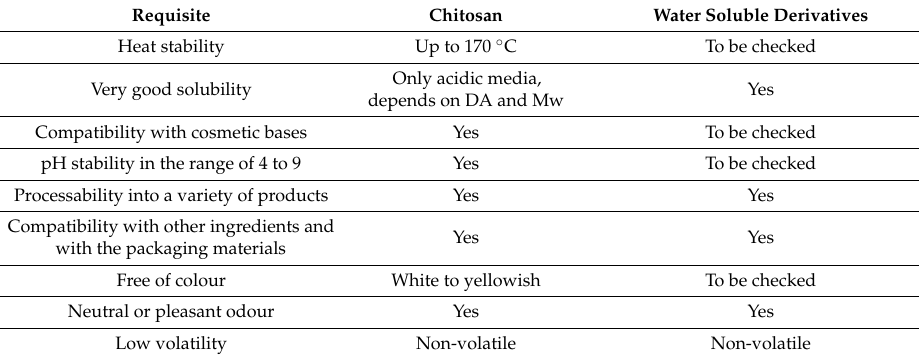
Table 7. Polymer requisites in hair